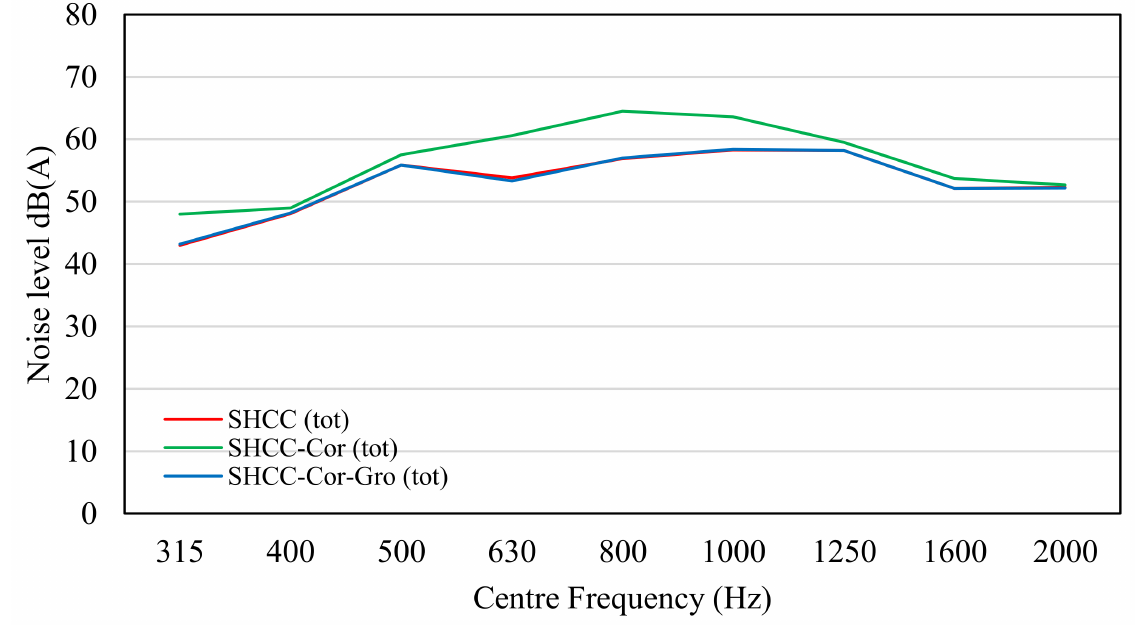
Figure 8. Total noise level of SHCC, modified SHCC-Cor, and SHCC-Cor-Gro.